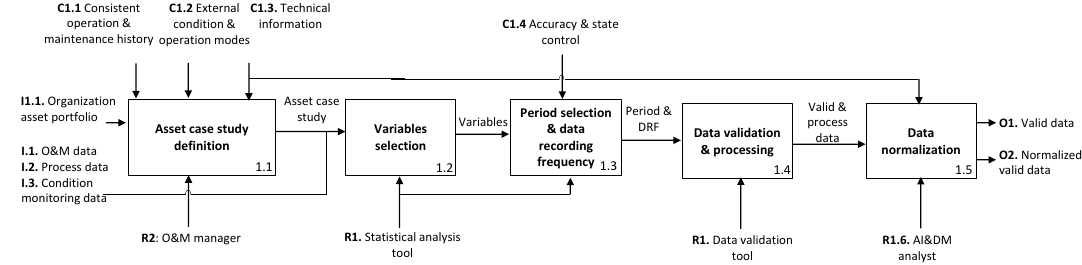
Figure 3. Level-2 representation of the Data Processing process.